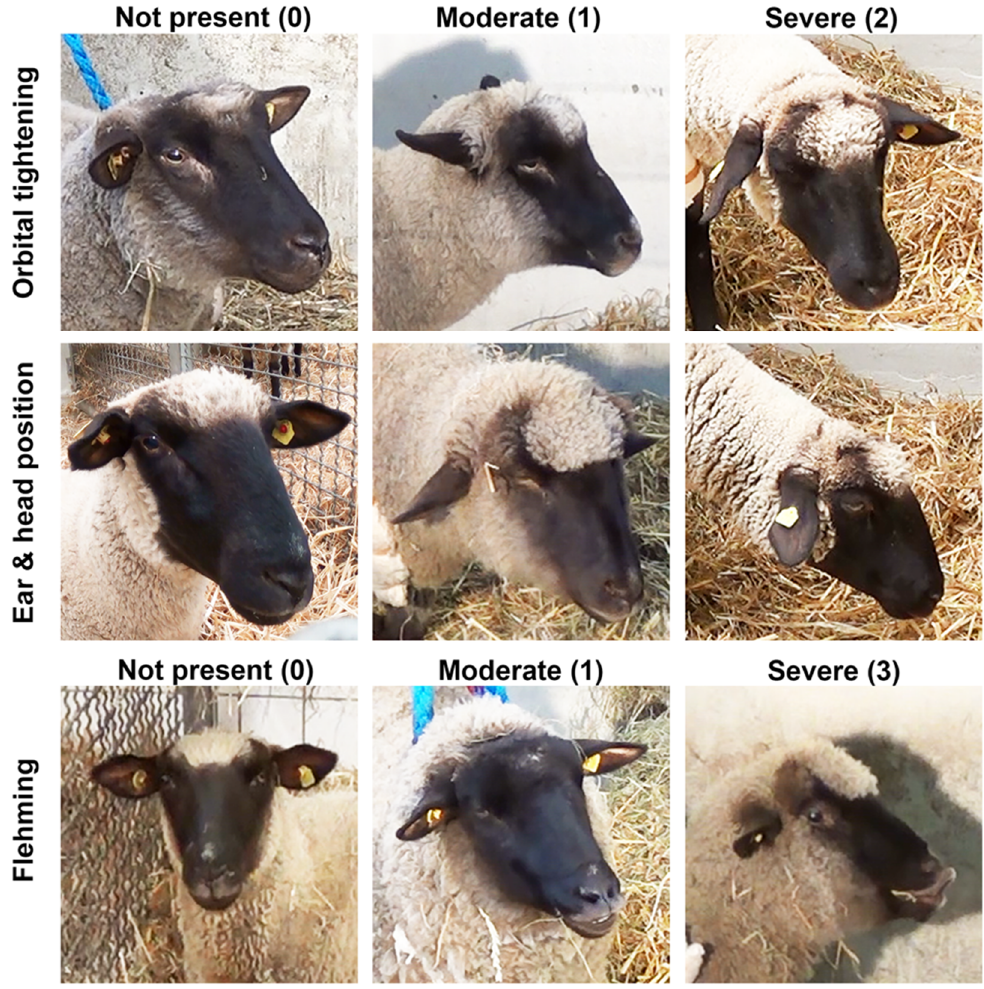
Figure 3. Action Units of the Sheep grimace scale (SGS) [38].